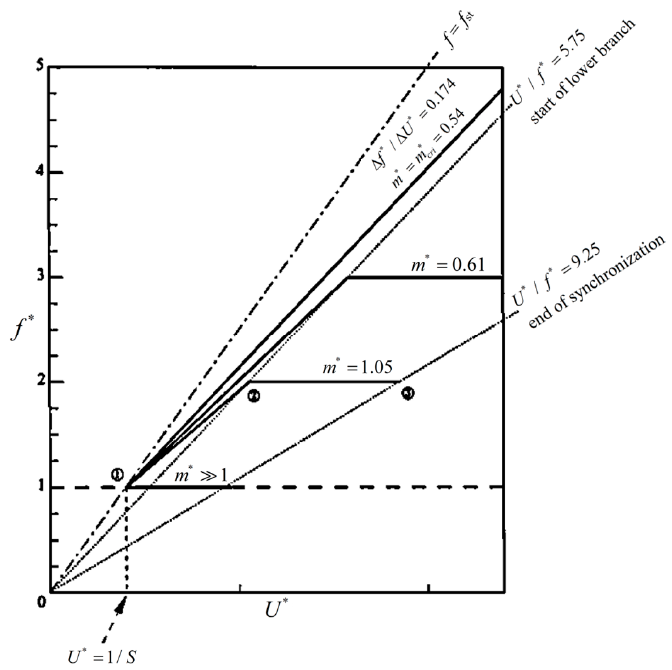
Figure 3. Frequency response of different mass ratios with low m* ζ [14].